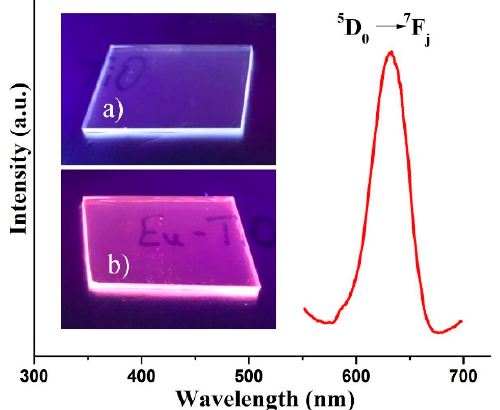
Figure 9. Room temperature emission of Eu-doped TiOx film. Inset are digital pictures of a) undoped and b) Eu-doped TiOx films under the excitation of commercially available UV lamp ( λ exc. =302 nm).